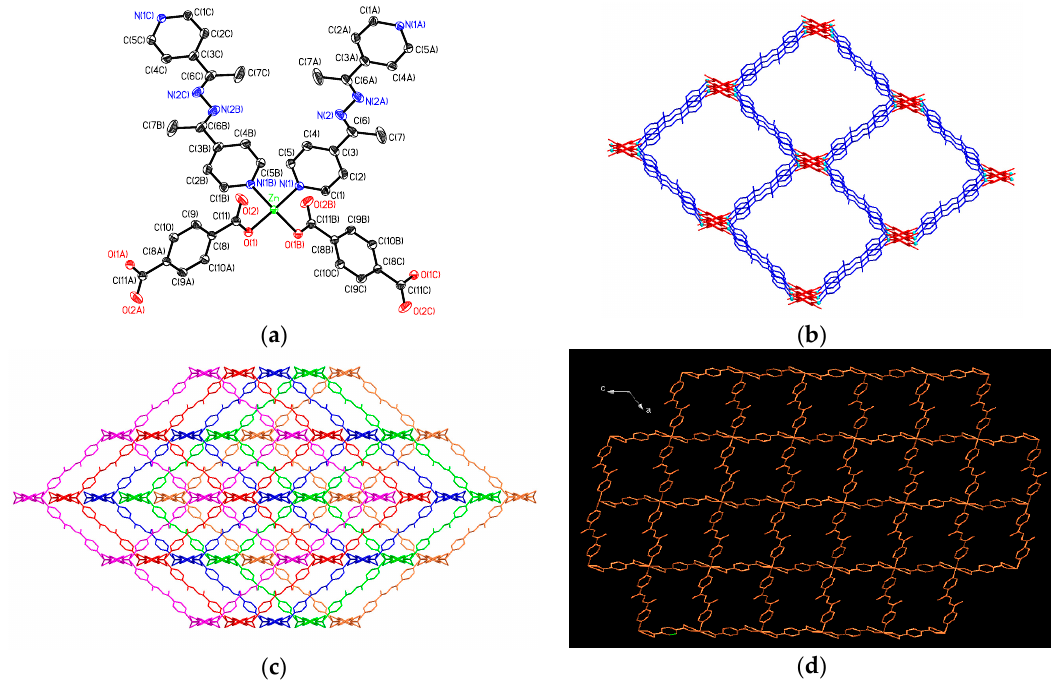
Figure 4. ( a ) Distorted tetrahedral coordination environments about Zn(II) ion in 4 with atom labelling scheme (ORTEP drawing, 30% thermal ellipsoids). The solvent molecules and H atoms are omitted for clarity; ( b ) The 3D diamondoid-like MOF; ( c ) The five-fold interpenetrating 3D supramolecular architecture of 4 ; ( d ) The one-dimensional (1D) channels created by the five-fold interpenetrating 3D architecture viewing along the b axis.